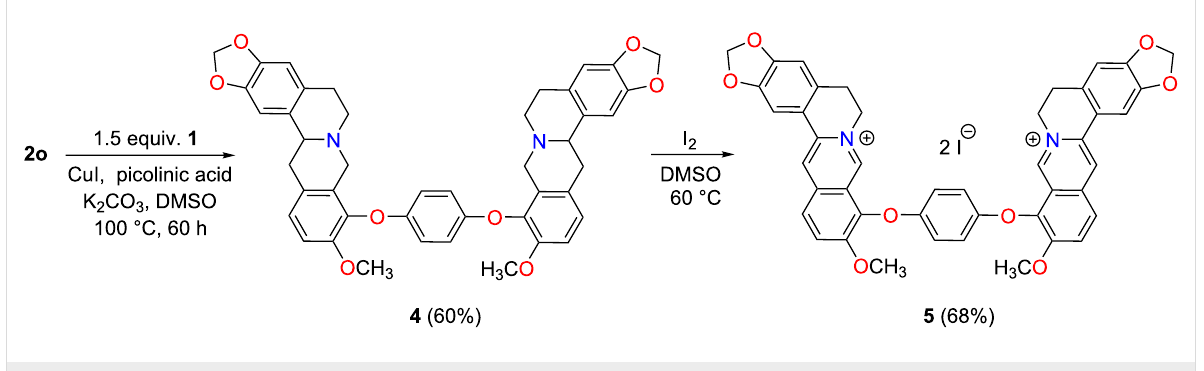
Scheme 4: 9-O-Ph-linked berberine dimer through double cross-coupling